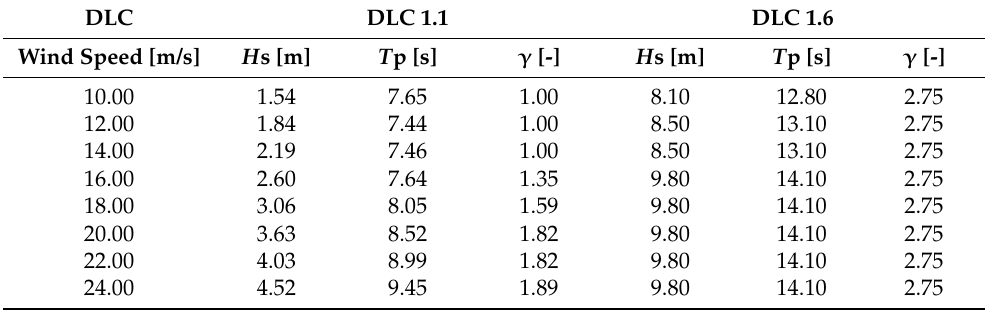
Figure 5. Time series of the tower-top pitch moments for the three specified conditions.